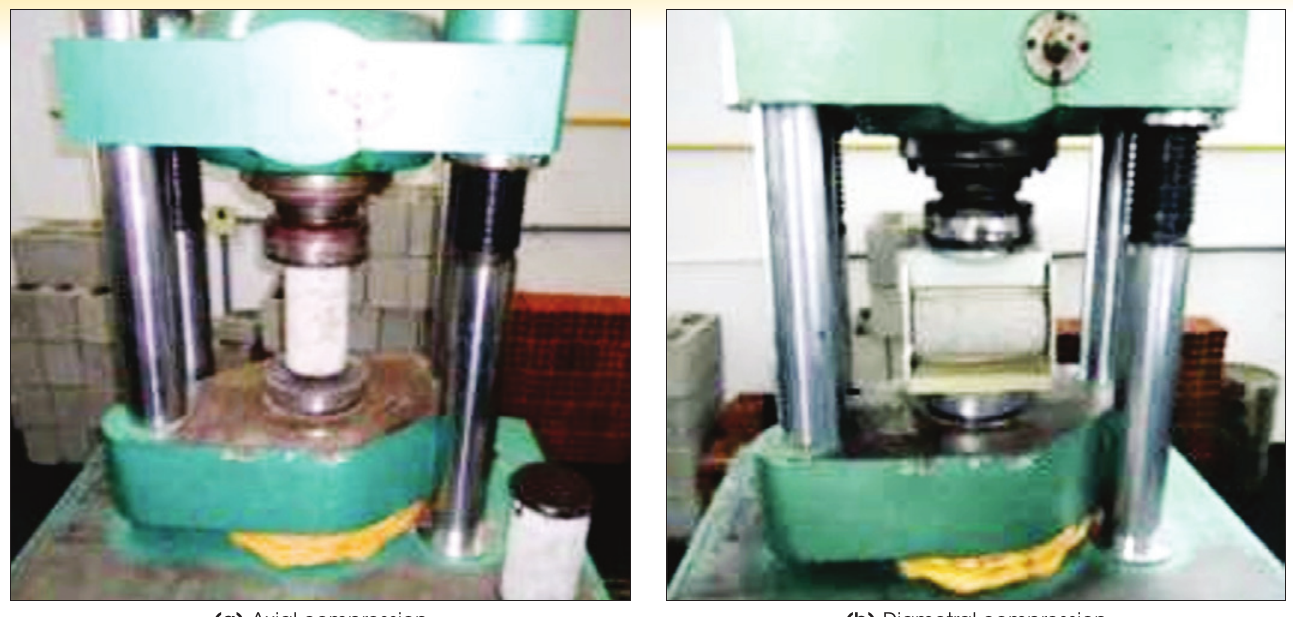
Specimens in failure position